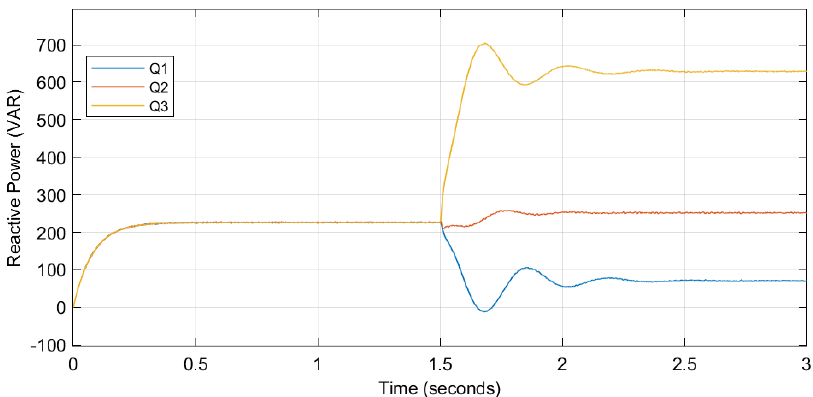
Figure 12. Active power output of the droop controller with proposed virtual impedance.